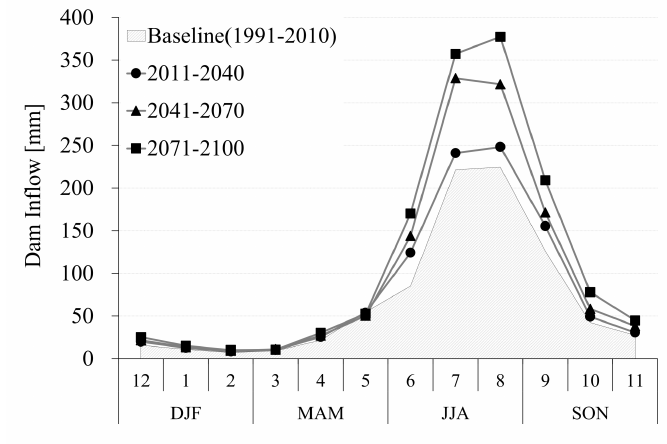
Figure 10. Variation of monthly runoff projection by three decadal